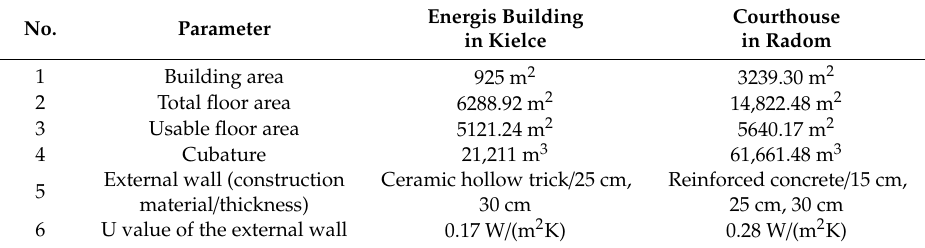
Table 1. The main technical data of the analysed intelligent buildings.